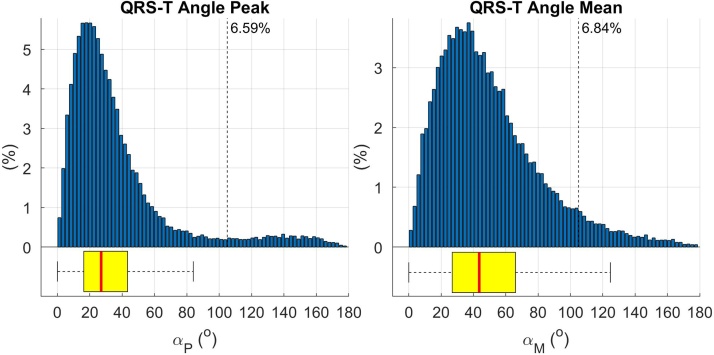
Histogram showing peak and mean QRS-T angle distributions for 34,150 individuals with a 12-lead ECG recorded in the UK Biobank study. Vertical dotted line shows cut off for abnormality (> 105°).